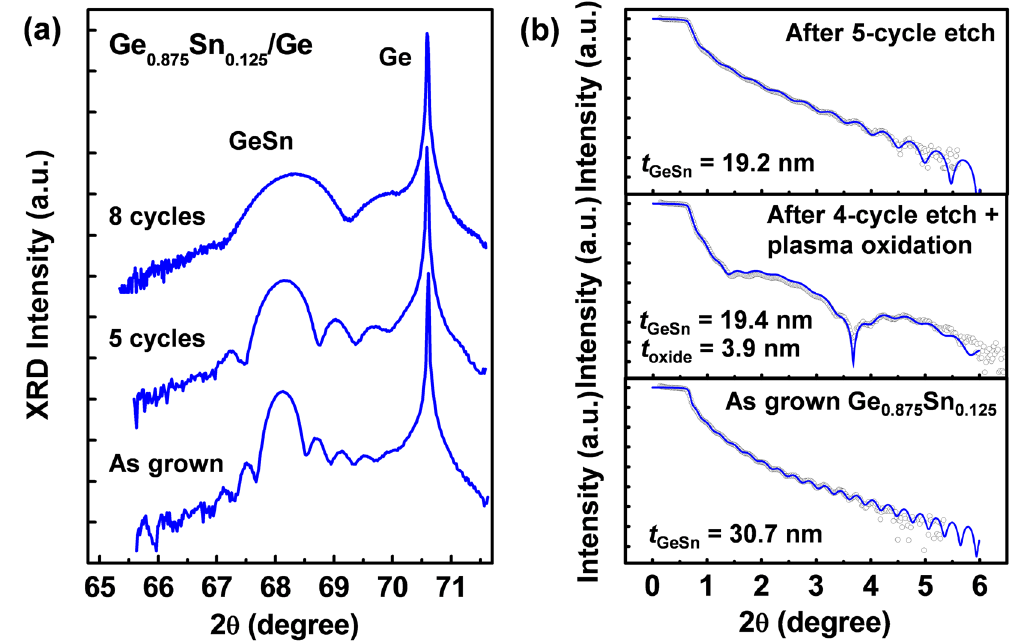
Figure 3. ( a ) (004) HRXRD curves of the as-grown Ge 0.875 Sn 0.125 , and the sample after 5-cycle and 8- cycle digital etch. ( b ) Experimental and simulated XRR curves of the as-grown Ge 0.875 Sn 0.125 , and the sample after 5 cycle plasma oxidation and HCl etch.